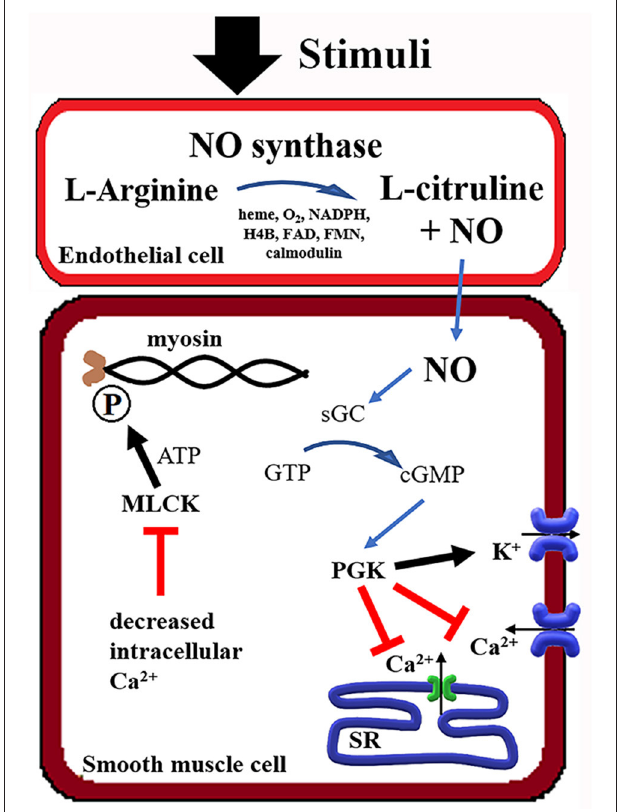
FIGURE 1 | Summary of the Nitric Oxide (NO) mechanism in smooth muscle relaxation. NADPH, Nicotine adenine dinucleotide phosphate; H4B, tetrahydrobiopterin; FAD, flavin adenine dinucleotide; FMN, flavin mononucleotide; GTP, guanosine triphosphate; cGMP, cyclic guanosine monophosphate; sGC, soluble guanylate cyclase; PGK, phosphoglycerate kinase; SR, sarcoplasmic reticulum; MLCK, myosin light-chain kinase; ATP, adenosine